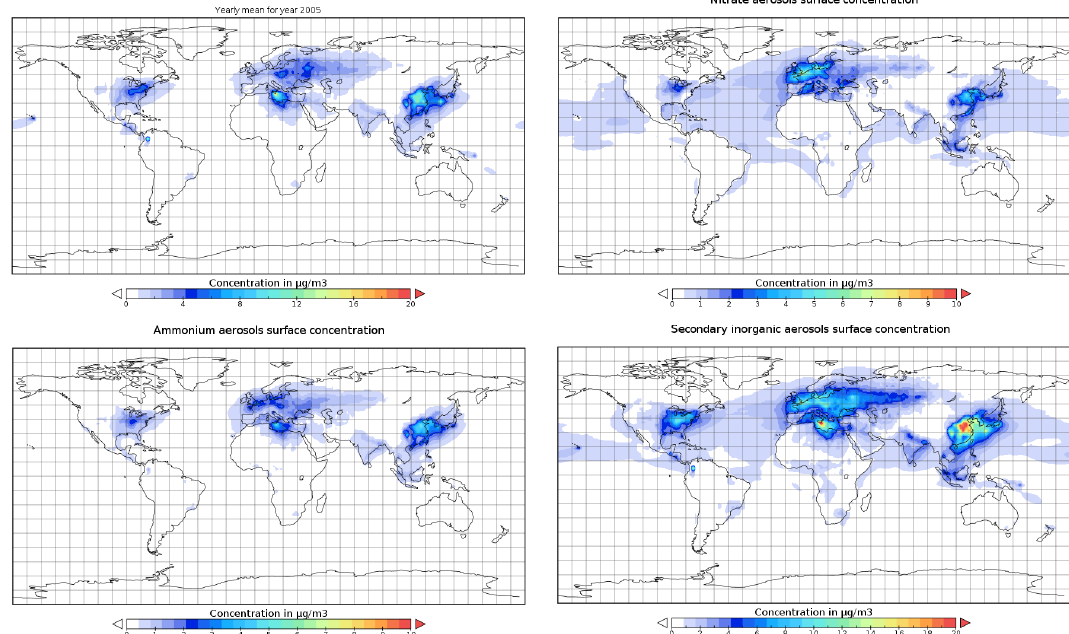
Figure 4. Maps of global annual mean concentrations at the surface, in µgm − 3 , of secondary inorganic aerosol components from the RACMSIA simulation. The top left panel is sulfate, the top right panel nitrate, the bottom left panel ammonium, and the bottom right panel is the sum of the three components.